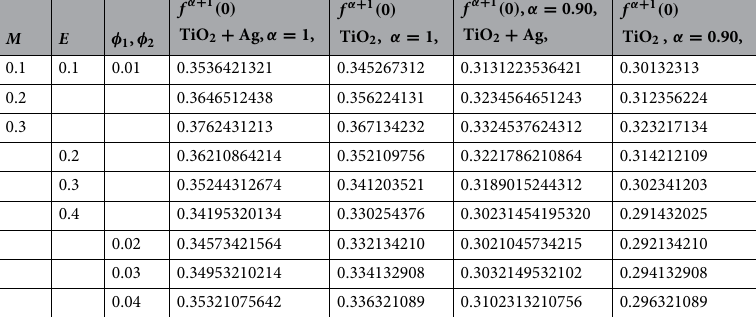
Table 2. Skin friction versus embedded parameters using both cases. When Pr =